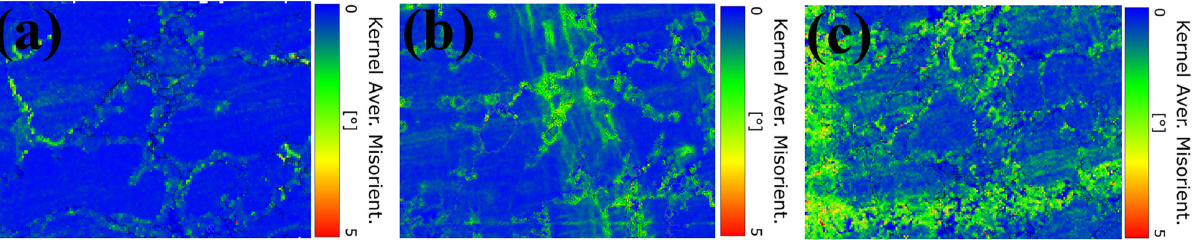
Figure 10: Deformation of Ag ( s.s ) and Cu ( s.s ) within the brazing seam. ( a ) 0%; ( b ) 2%; and ( c ) 3%.